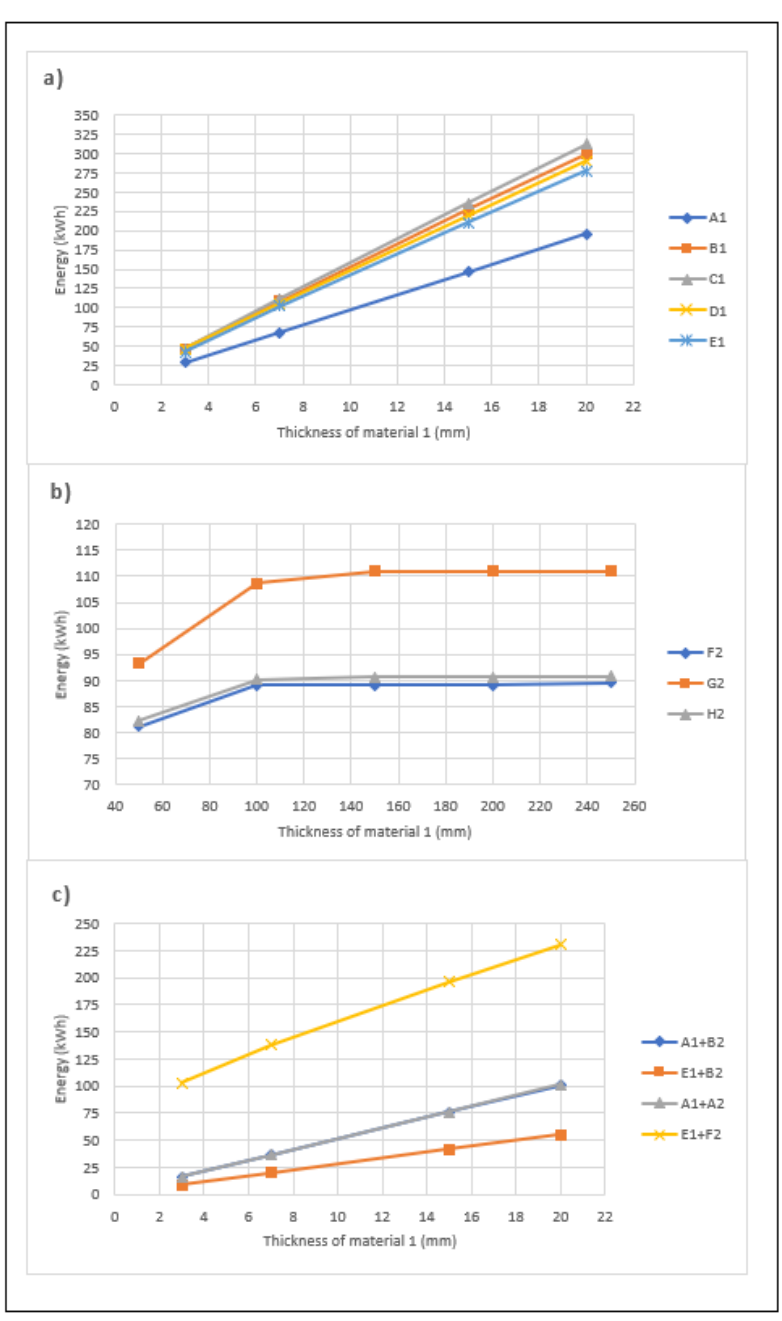
Figure 4. Heat supplied to the sidewalls for different thicknesses and configurations. ( a ) metallic materials (configuration I); ( b ) ceramic materials (configuration I); and ( c ) material composition (configuration II or III-no pivoting sidewall).